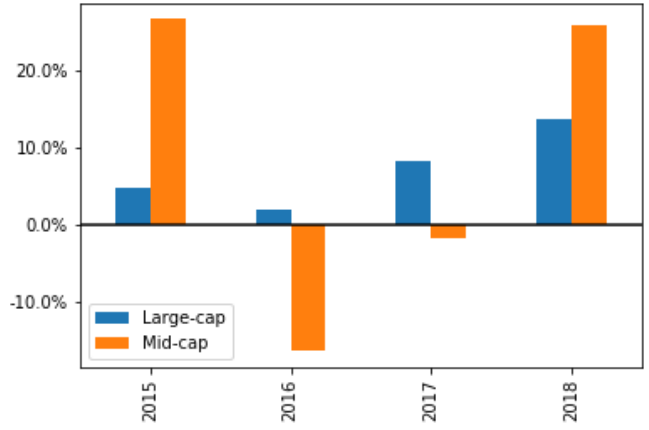
Figure 8. ESG mentions by market-cap